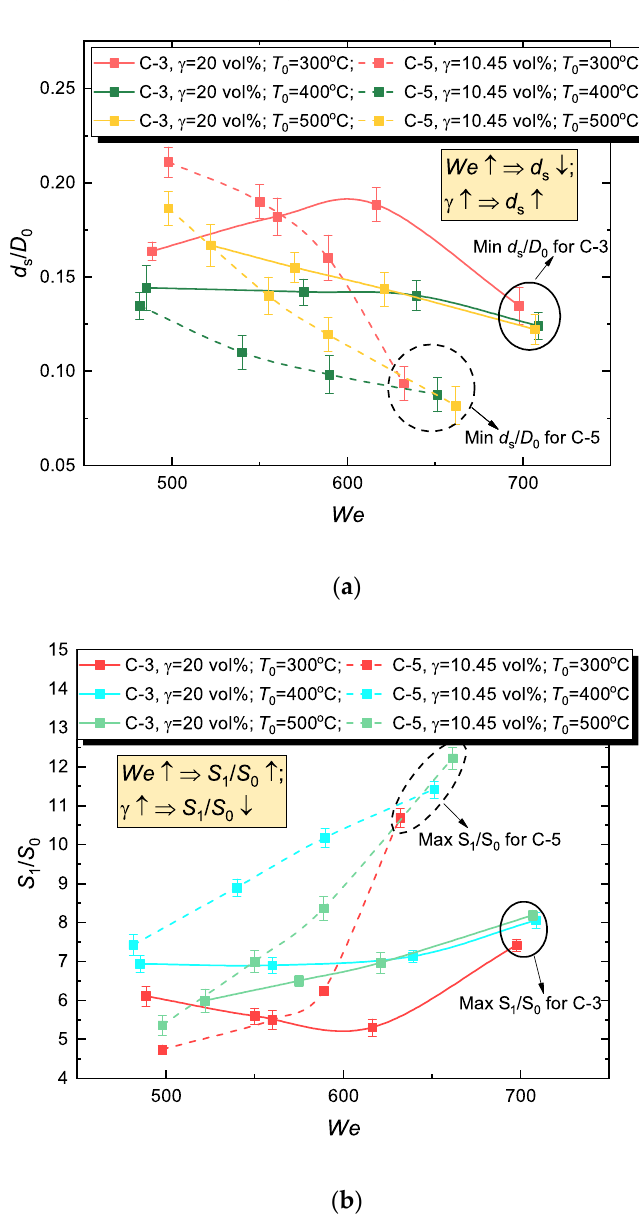
Figure 10. Effect of emulsifier concentration in WiBDME (C-3 and C-5) on hydrodynamic disintegration characteristics of corresponding fuel droplets (mean child droplet diameter ( a ) and evaporation surface area ( b ) at various surface temperatures).